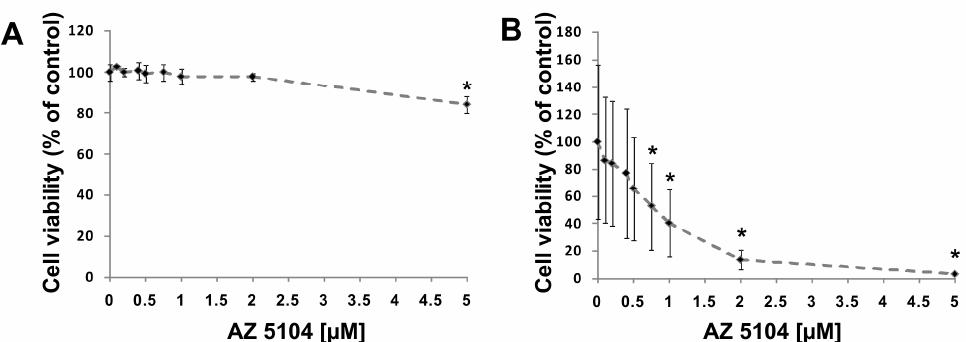
Figure 2. Individual cytotoxic effects of AZ5104. ( A ) Results of the neutral red uptake assay in HepG2 cells treated with increasing concentrations of AZ5104 for 24 h. Mean ± SD, n = 6. ( B ) Results of cell viability determined with the CellTiter-Glo assay in CD4+ cells differentiating towards Th17 cells in the presence of AZ5104 for 5 days. Mean ± SD, n = 8. * p < 0.05 compared with control cells.